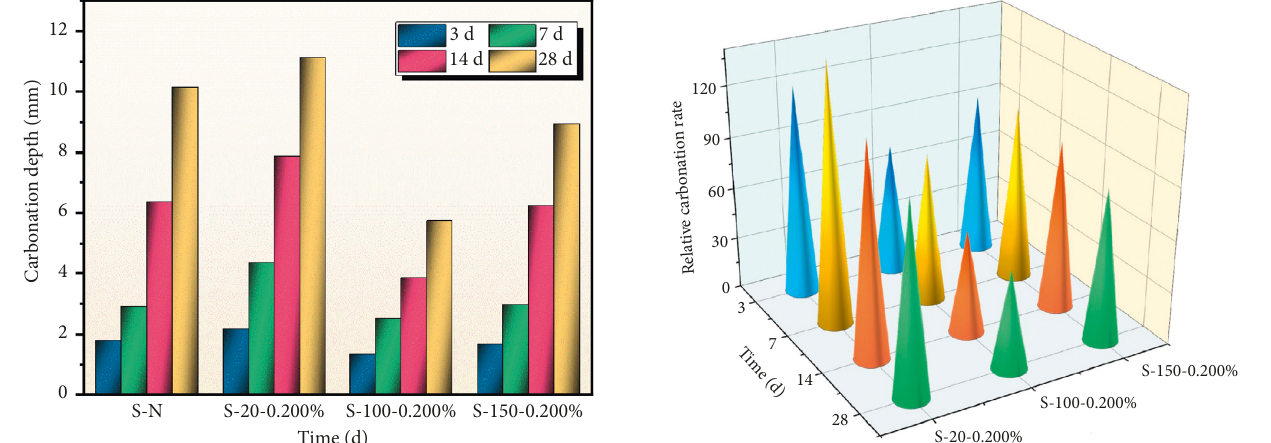
Figure 7: Relative carbonation rate of concrete with SAP of dif- ferent sizes. time, the effect of SAP particle size on the hydration of cement was studied by analyzing the FTIR spectra of day 56 (Figure 11).